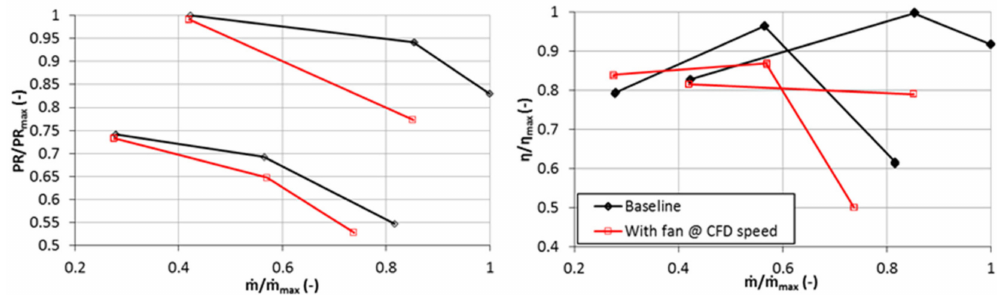
Figure 10. Comparison of compressor stage performance parameters at 120 krpm and 160 kpm. (Reproduced with permission from Taylor & Francis Group, ©2021